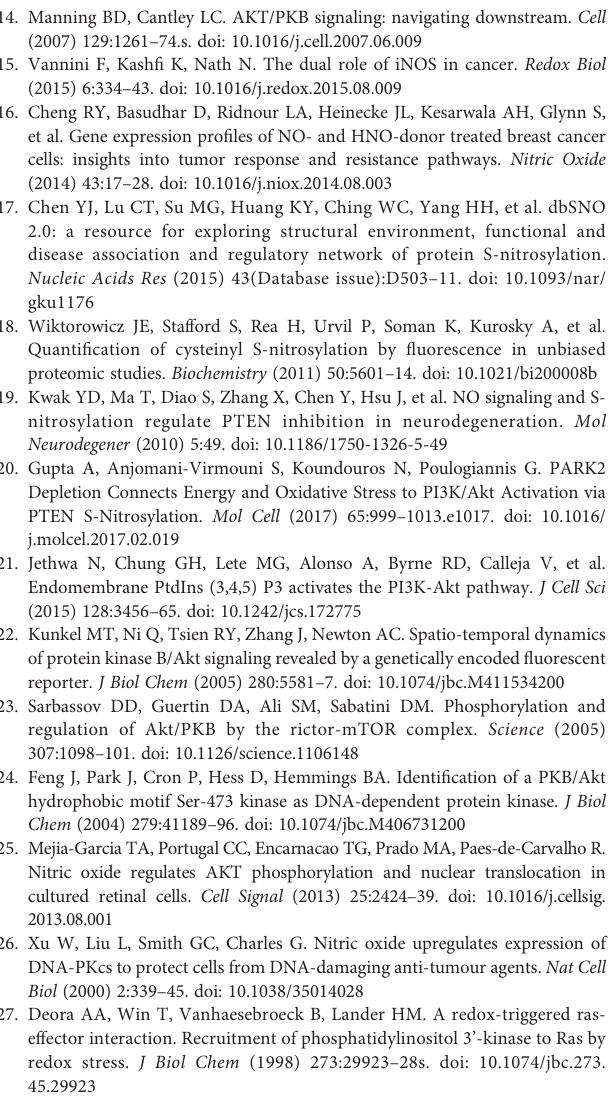
Supplementary Figure 1 | Sample Tumor iNOS and PTEN expression characteristics by immunohistochemical analyses. Stage III melanoma tissues from patients were immunostained for iNOS and PTEN, Scale 10X. As published previously (8), both intensity and percentage of positive cells were quanti fi ed and protein expression associating with overall survival (OS) in this retrospective tissue